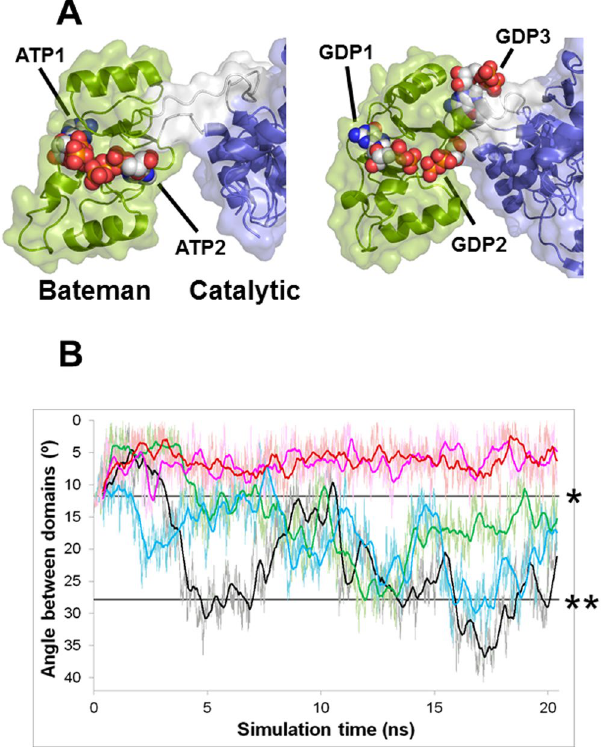
Figure 4. GDP2 and GDP3 staple the catalytic and Bateman domains into a fixed inhibited conformation. ( A ) Cartoon and surface representation of a monomer of AgIMPDH-ATP (left) and AgIMPDH-GDP (right). Nucleotide atoms are shown as spheres. The catalytic domain is coloured in blue, the Bateman domain in green and the hinge bending residues (linkers) in grey. ( B ) Angle formed between the mass centers of the catalytic, linker and Bateman domains of a monomer of AgIMPDH bound to different nucleotides during the molecular dynamics computer simulations. Black: APO, blue: GDP1/GDP2, green: ATP1/ATP2, pink ATP1/GDP2/GDP3, and brown: GDP1/GDP2/GDP3. The thin lines show the raw data and the smoother thick lines are the mobile mean of the angle along 20 structures. The straight black lines marked with one or two asterisks indicate the angles formed in the structures of AgIMPDH-GDP (starting structure for all simulations) and AgIMPDH-ATP,